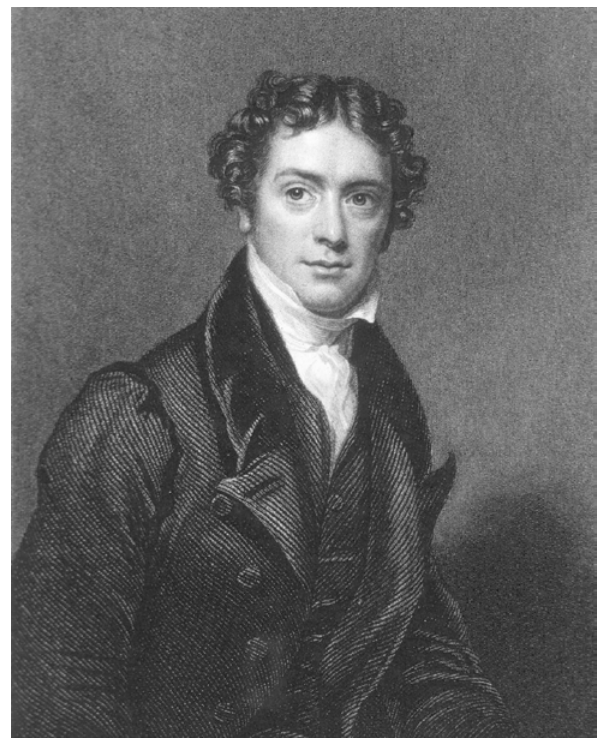
Figure 3. Michael Faraday in his thirties [5].